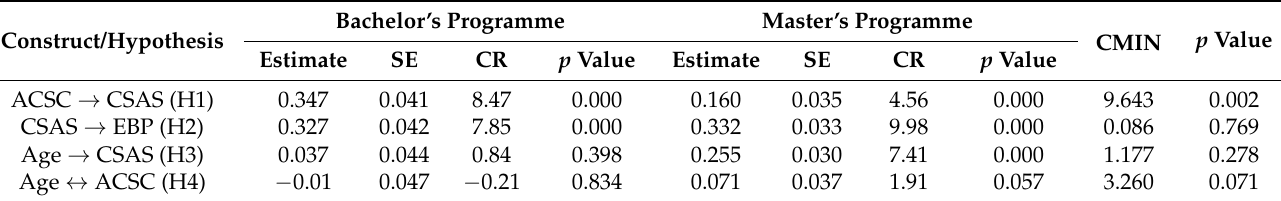
Table 3. Standardised regression weights and test invariance across